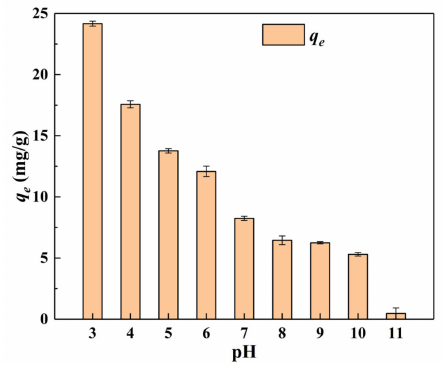
Figure 5. Changes in equilibrium adsorption capacity of Cr(VI) with pH value.